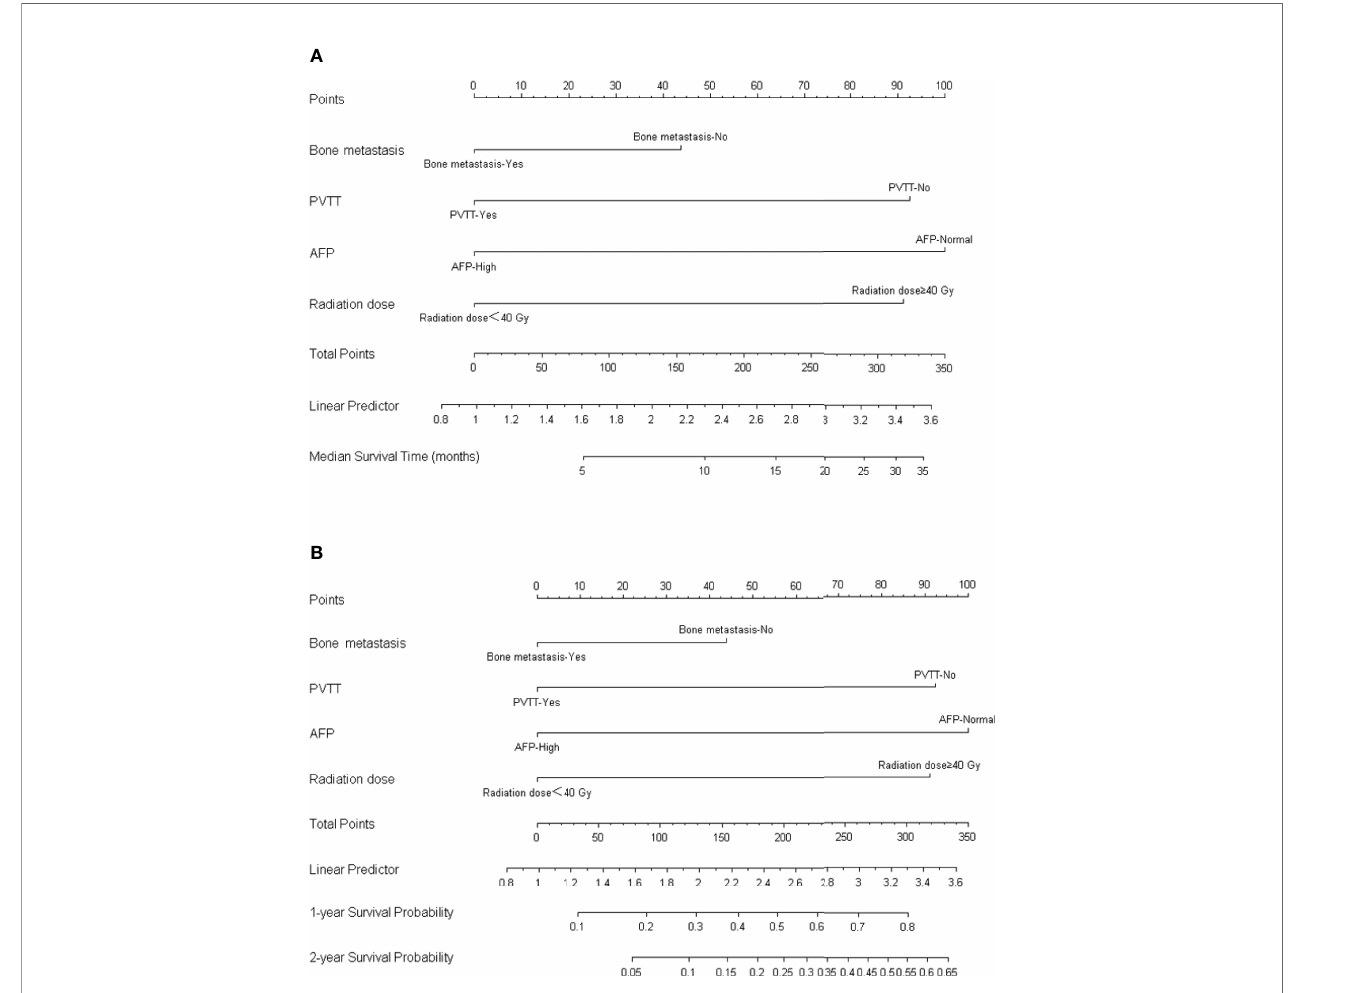
FIGURE 3 | Nomogram for predicting the median OS (A) and 1-year/2-year survival probability (B)